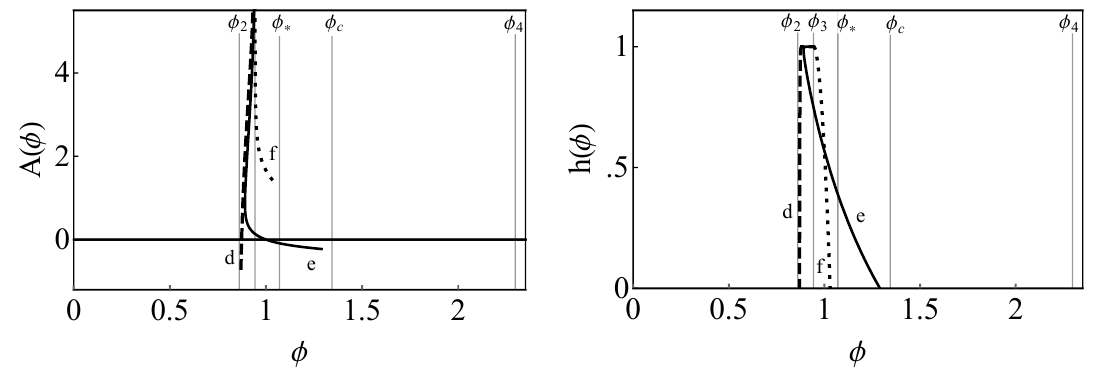
Figure 12 . Several numerical solutions of the bulk geometry with values of (cid:30) H in region II. Solution d is an example with (cid:30) H in region IIa, solution e with (cid:30) H in region IIc and f (cid:30) H in region IIb.